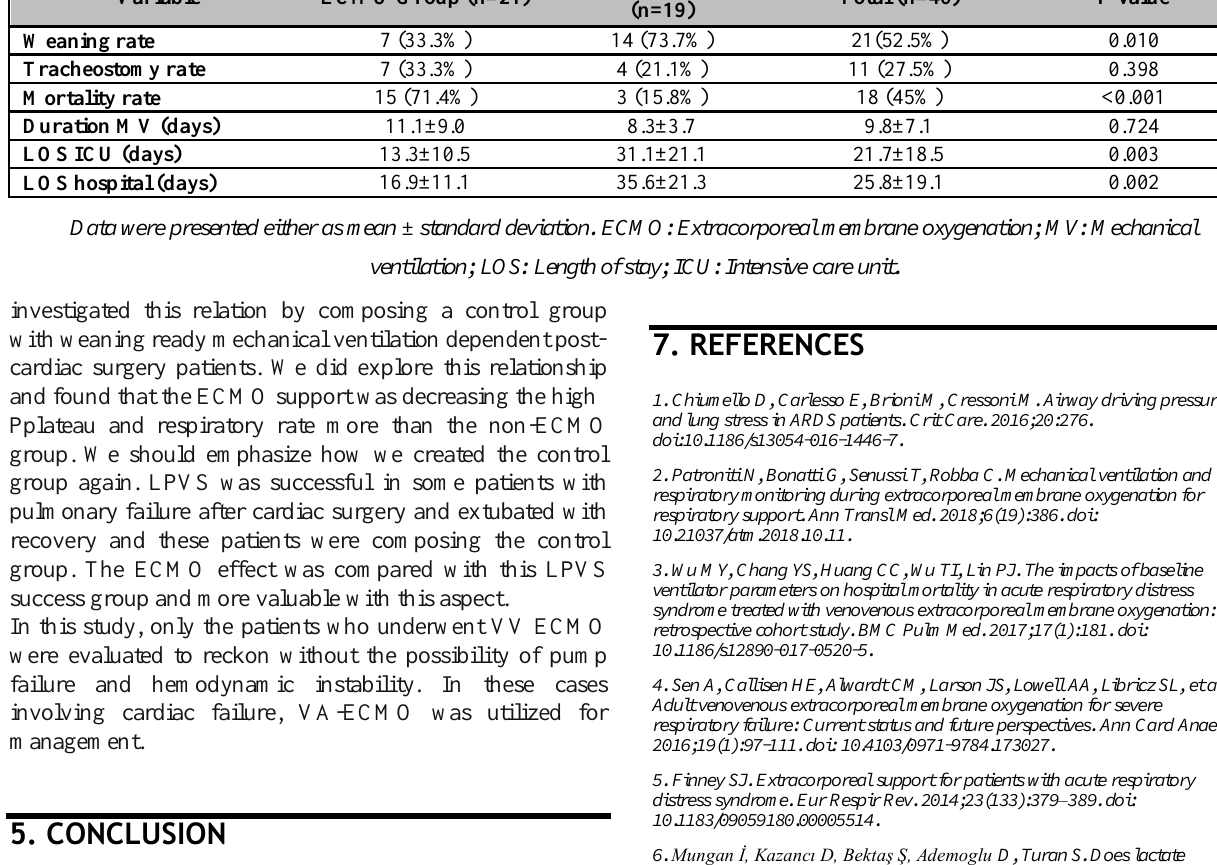
Table 3. ECMO and non-ECMO groups mortality rates and outcomes